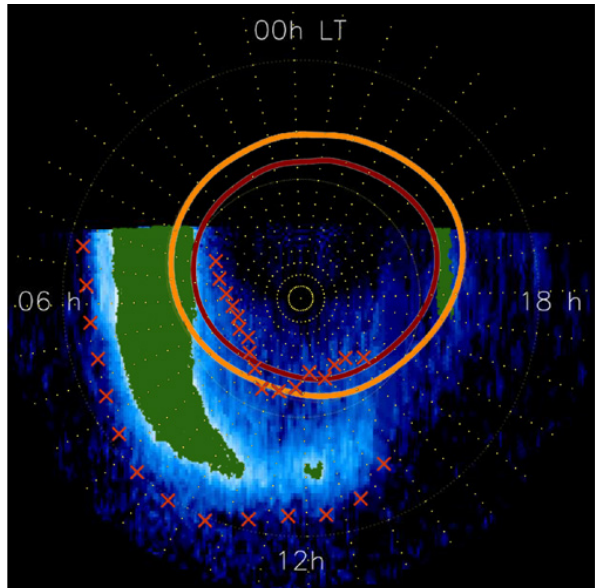
Fig. 5. Plot showing HST UV image A of Saturn’s southern aurora, projected onto a spheroidal surface 1100km above the atmospheric 1-bar level, with noon at the bottom and dawn to the left. The view is thus ‘through’ the planet from the north. Dotted lines show a latitude–longitude grid at 10 ◦ intervals. The locations of the pole- ward and equatorward boundaries of the emission are shown by red crosses, determined at 10 ◦ intervals of longitude from a 5kR lim- iting emission intensity. The superposed solid orange curve shows the open field region for k S = 0 . 2, dipole planetary field and spher- ical ionosphere. The brown curve marks the open field region for the multipole magnetic field and spheroidal ionosphere. Green ar- eas mark regions of bright emission (a large dawn auroral patch, a narrow dusk arc aligned in the noon–midnight direction, and a small bright spot near noon) with brightness higher that 16% of the local maximum brightness in each region.